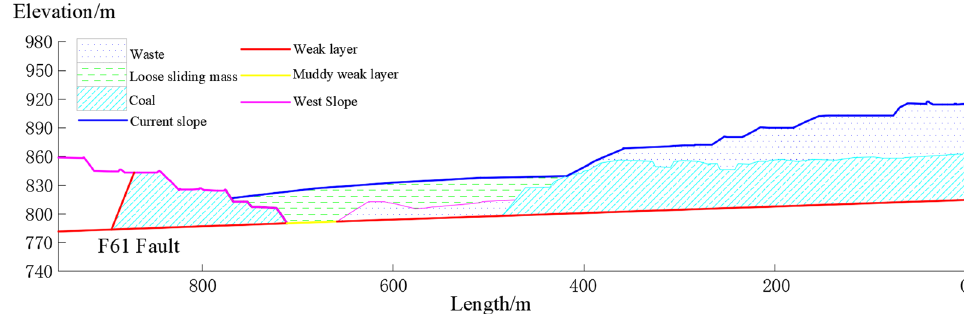
Fig. 10 Typical engineering geology of inner dump